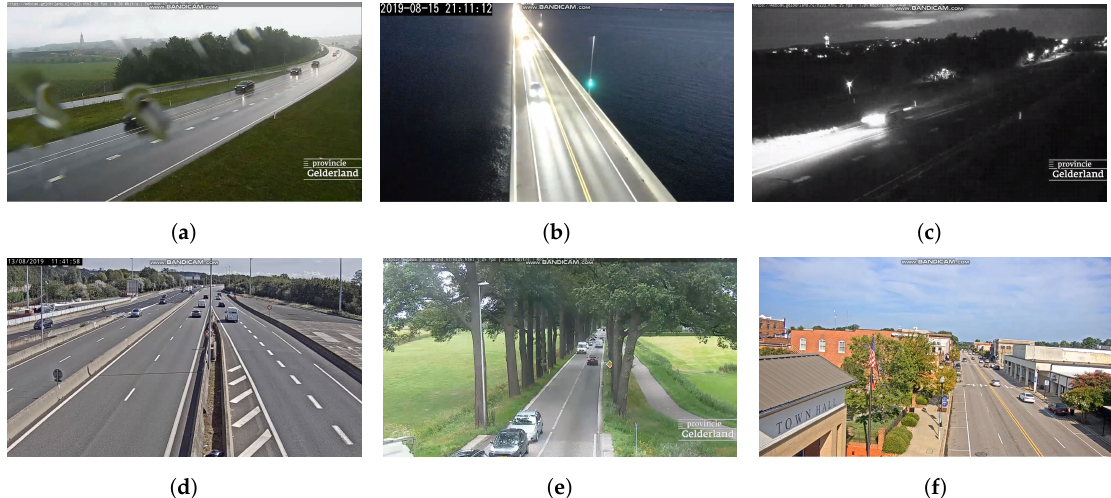
Figure 14. Known limitations in different environmental situations. Rainy conditions can smudge the camera ( a ). However, if there is not too much spray from the vehicles tracking is possible. Night situations with artificial light ( b ) or complete darkness ( c ) decrease the performance of the system rapidly. In some cases it is not even possible to detect a vehicle. Highways with multiple lanes and exits lead to difficulties estimating driving paths ( d ), rapid congestions, e.g., due to traffic lights impose complications in terms of tracking ( e ). Furthermore, parked vehicles in towns are also considered as active objects resulting in wrong driving paths ( f